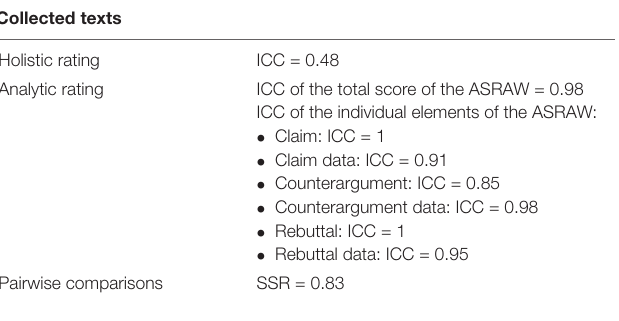
TABLE 3 | Reliability measures per rating procedure.